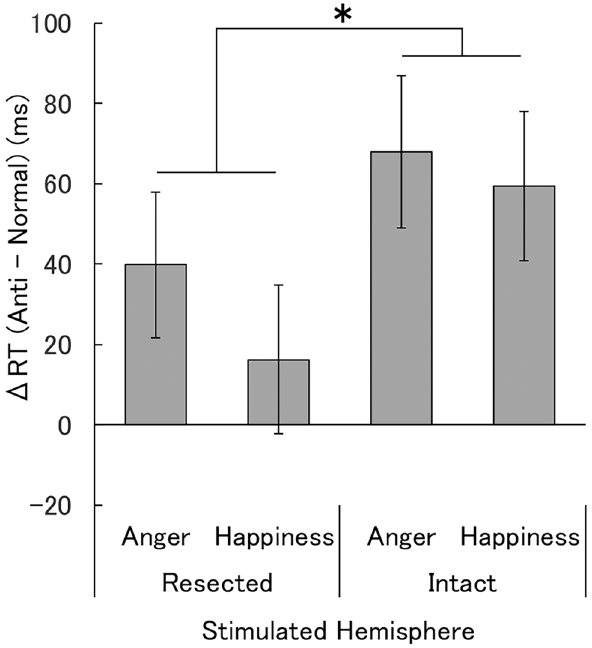
Figure 3. Mean (± SE ) reaction time (RT) differences between the normal-expression and anti-expression conditions in temporal-lobe-resected patients. Asterisks indicate a significant simple main effect of stimulated hemisphere, indicating larger RT differences when the target faces were presented to the contralateral visual field (i.e., stimulation of the intact hemisphere) compared with the ipsilateral visual field (i.e., stimulation of the resected hemisphere). * p < 0.05.